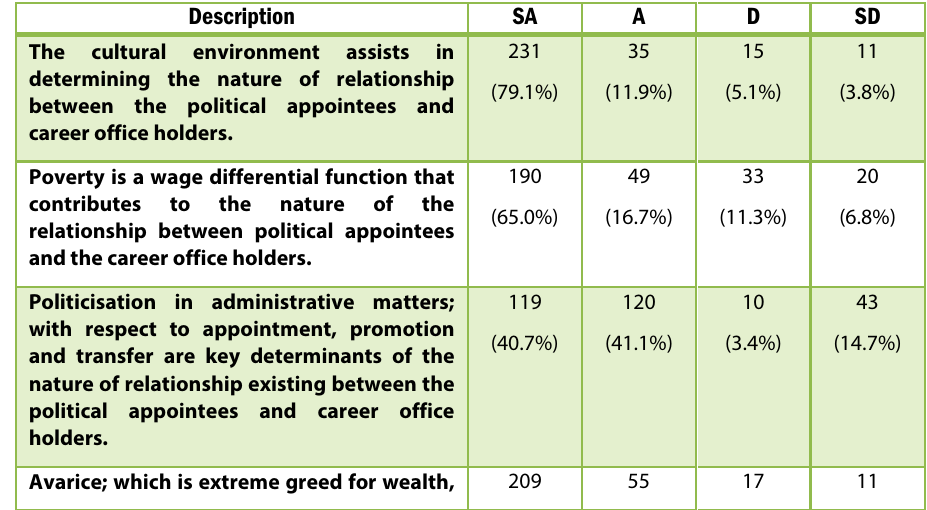
Table 2: Factors Influencing the Interface of Public Servants and Political